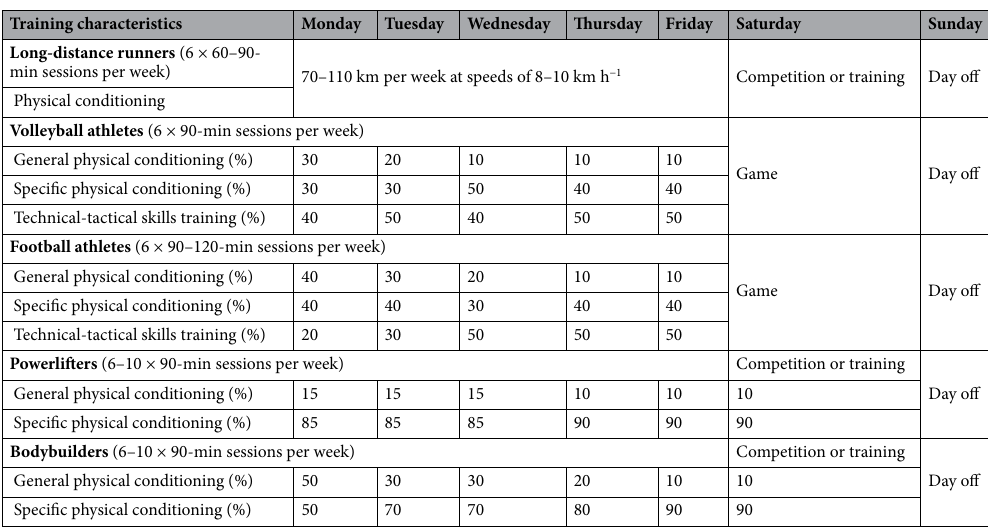
Table 1. Percentage (%) of the total daily training time devoted to general physical conditioning, specific physical conditioning, and/or technical-tactical skills training in each athlete group. General physical conditioning in volleyball and football athletes included continuous running, short sprints, plyometric jumps, upper-extremity exercises, and trunk and core stability exercises; Specific physical conditioning in volleyball and football athletes included jumps and sprints combined with technical exercises aimed at improving sprinting speed and agility with and without the use of balls; General physical conditioning in powerlifters included jogging on a treadmill at 4–6 km·h −1 ; Specific physical conditioning in powerlifters (60–95% of